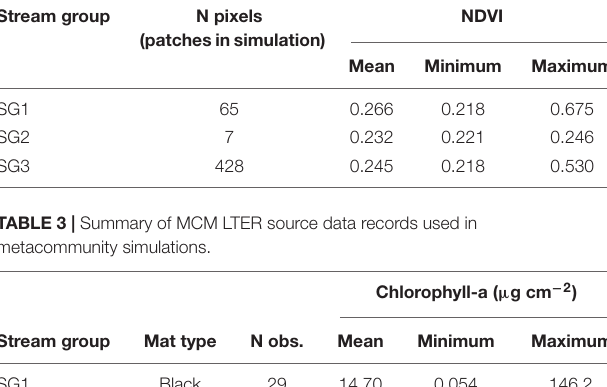
TABLE 2 | Summary of NDVI source data used in metacommunity simulations. Stream group